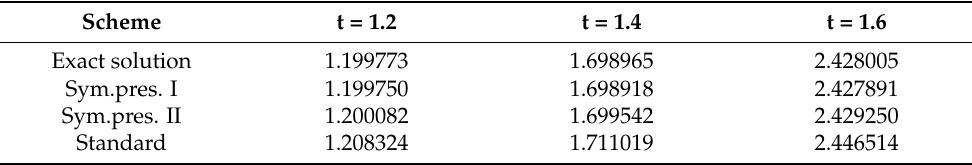
Figure 2. Solutions for the symmetry preserving schemes (49) for h = 0.1; h = 0.01; h = 0.001, and the exact solution of Hamiltonian system. Table 1. Values of the solution at points 1.2, 1.4 and 1.6 for mesh size h = 0.01.